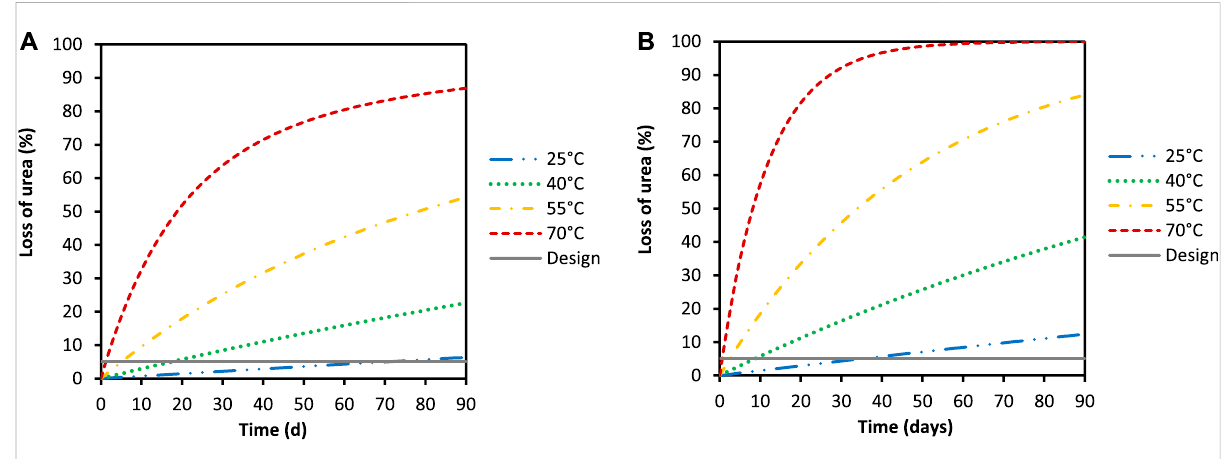
Loss of urea for a saturated Ca(OH) 2 -urine solution at different operating temperatures and two hypothetical scenarios: scenario (A) has constant 10 L day − 1 in fl ow to the urine stabilization tank (CSTR mode) while scenario (B) has no urine in fl ow (batch mode). There was no CO 2